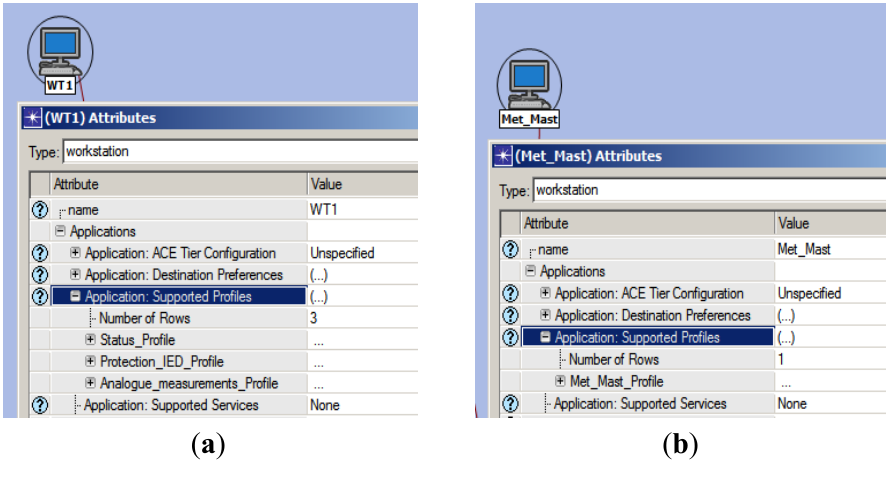
Figure 7. ( a ) Application types of wind turbine; ( b ) Application of meteorological